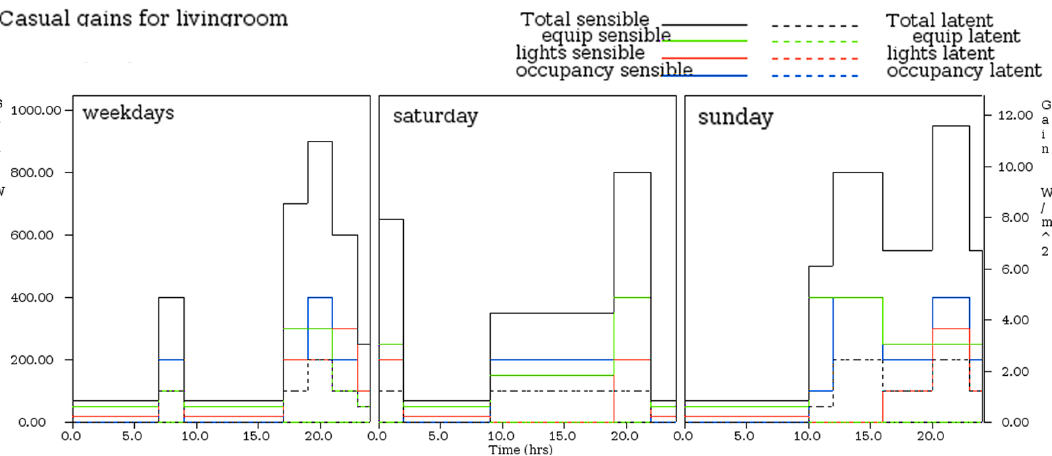
Figure 5. ESP-r model views from the Sun (east facade, morning of 17 August).